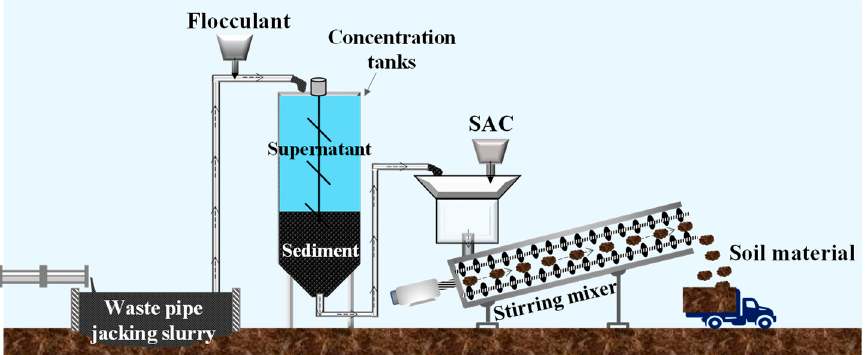
Figure 12. Schematic diagram of flocculation-sedimentation and solidification combined